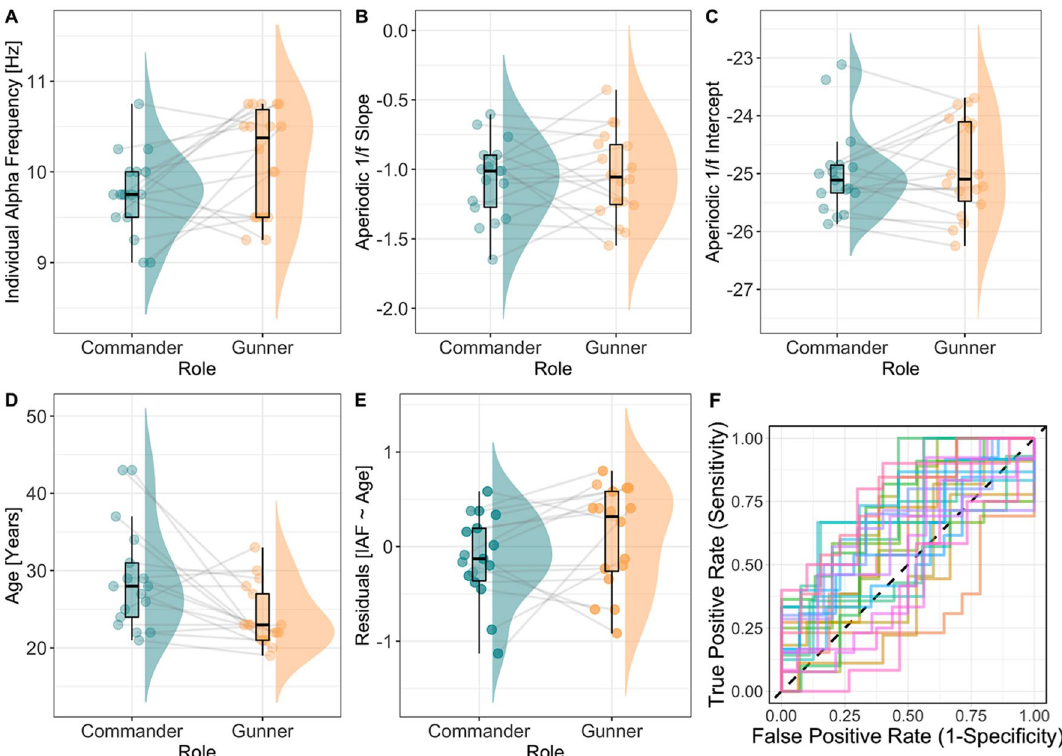
Figure 7. Boxplots illustrating difference in resting-state EEG between gunners and commanders. ( A ) IAF is represented on the y-axis, with higher values indicating a higher IAF. ( B ) The 1/ƒ slope is represented on the y-axis, with higher values reflecting shallower slopes. ( C ) The 1/ƒ intercept is represented on the y-axis, with higher values indicating a higher intercept. ( D ) Age (years) is represented on the y-axis, with higher values representing older age. ( E ) Residuals from the IAF ~ Age regression are represented on the y-axis, with positive values representing residuals above the regression line, negative values below the regression line, and values of zero indicating data points that are intersected by the regression line. Data points reflect individual participants, with joined data points between gunners and commanders representing specific pairs (e.g., dyads). ( F ) Region over the curve plot representing the logistic machine learning model. Each line represents one of the 25 bootstrapped resamples of the training